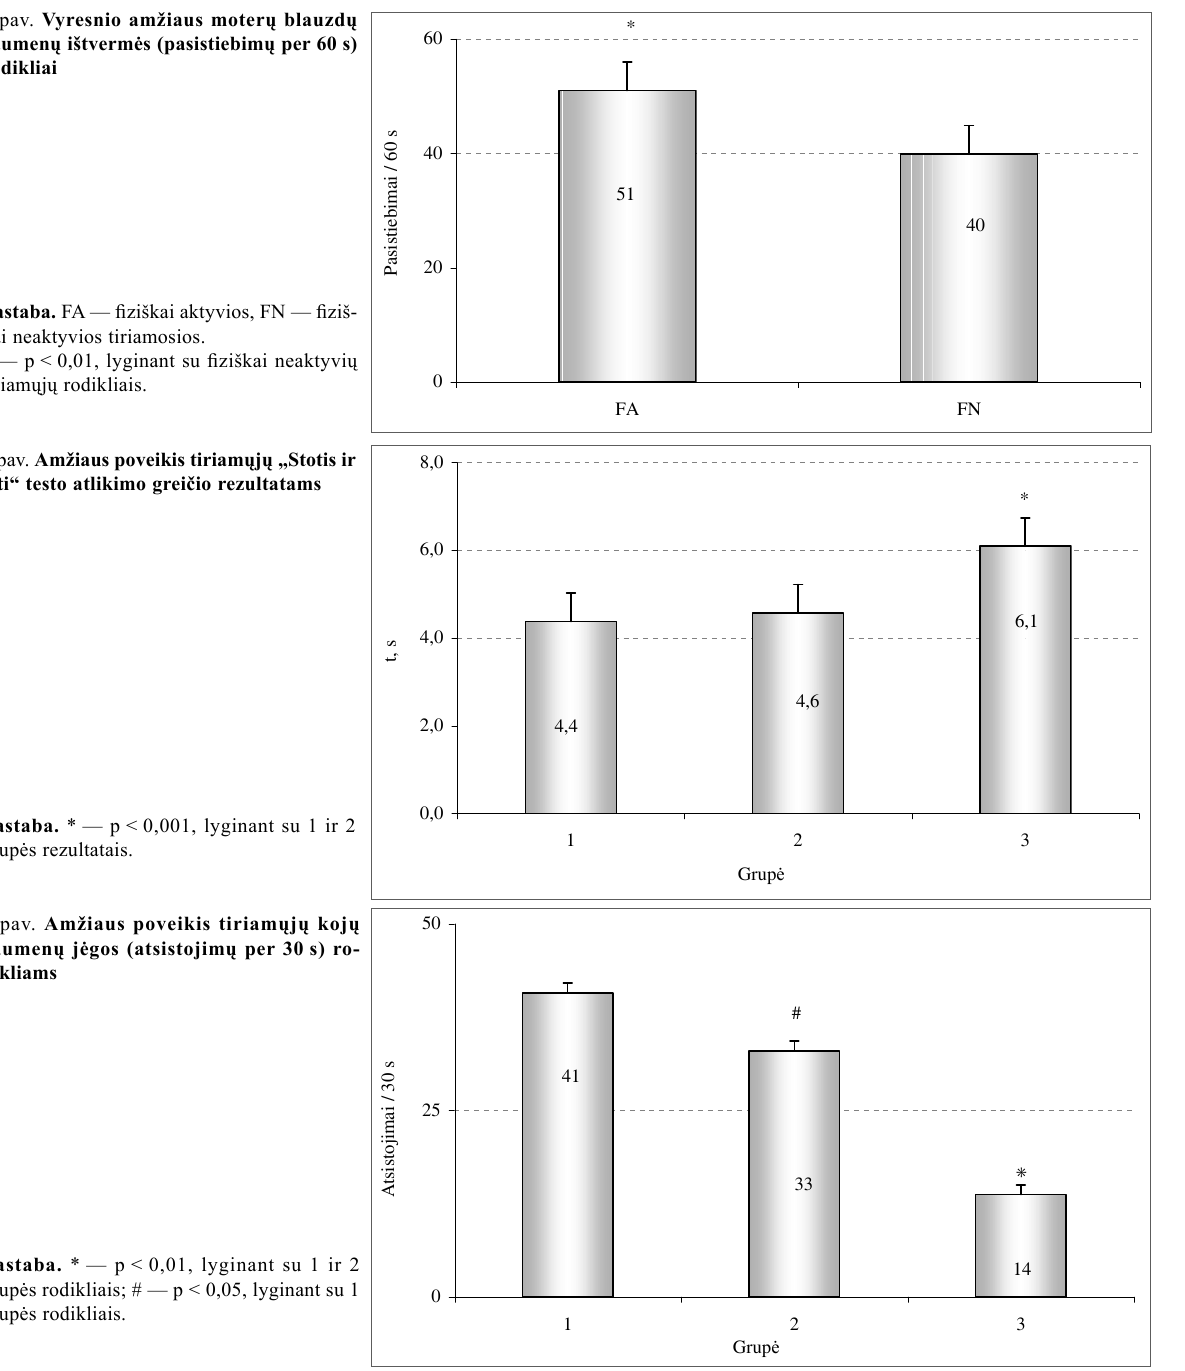
statistiškai reikšmingai mažesni nei III grup ė s tiria-